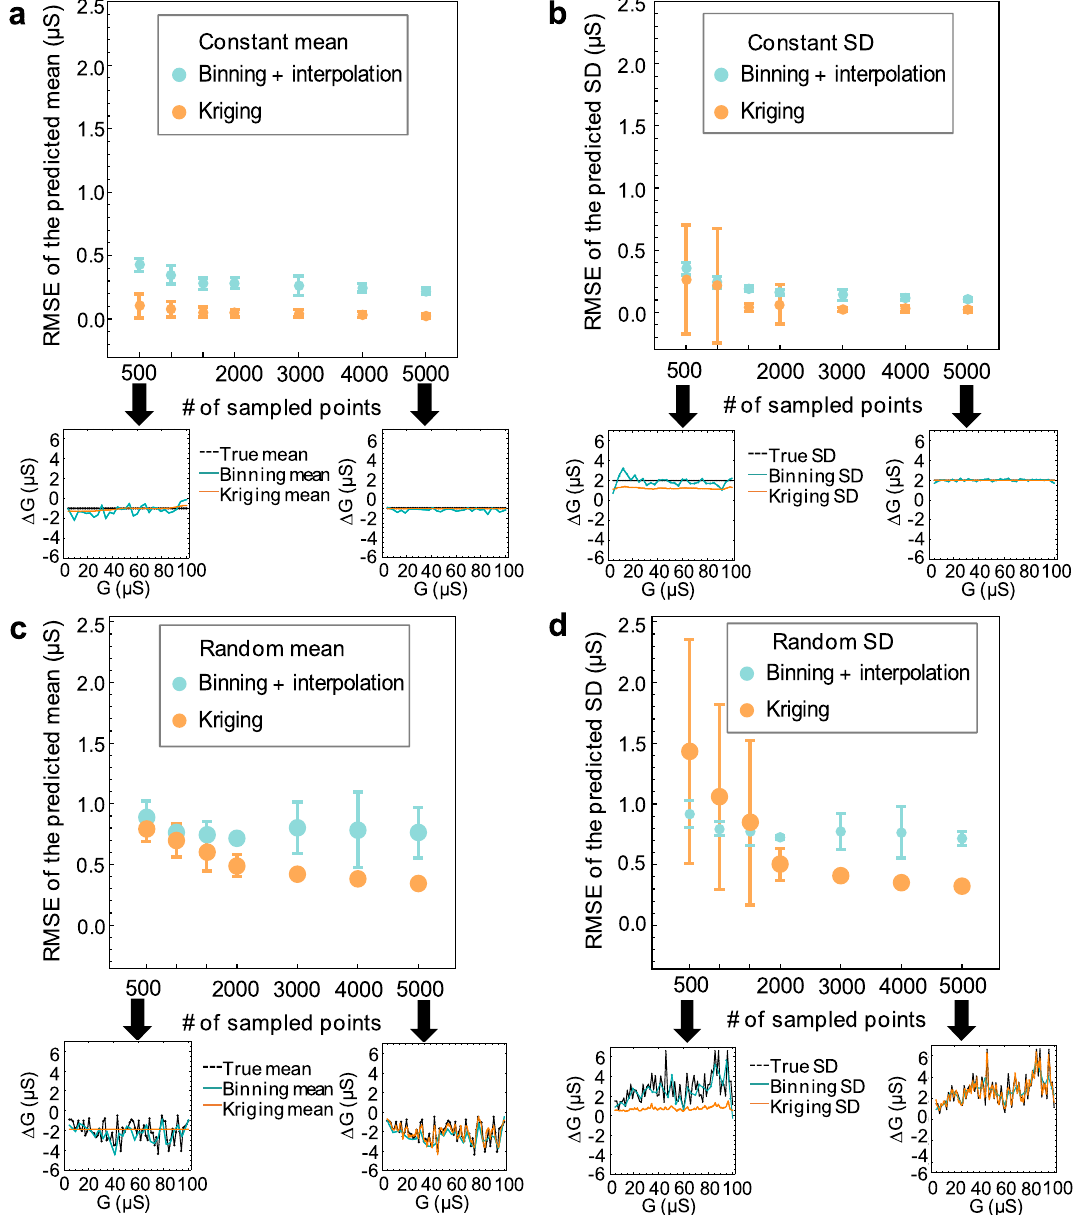
Figure 4. Prediction RMSE of Binning and Kriging model vs. number of sampled points in the dataset. ( a , b ) prediction of the mean and SD for the constant distribution model and ( c , d ) for the random distribution model R2. # of iterations = 20 and the error bar indicates one standard